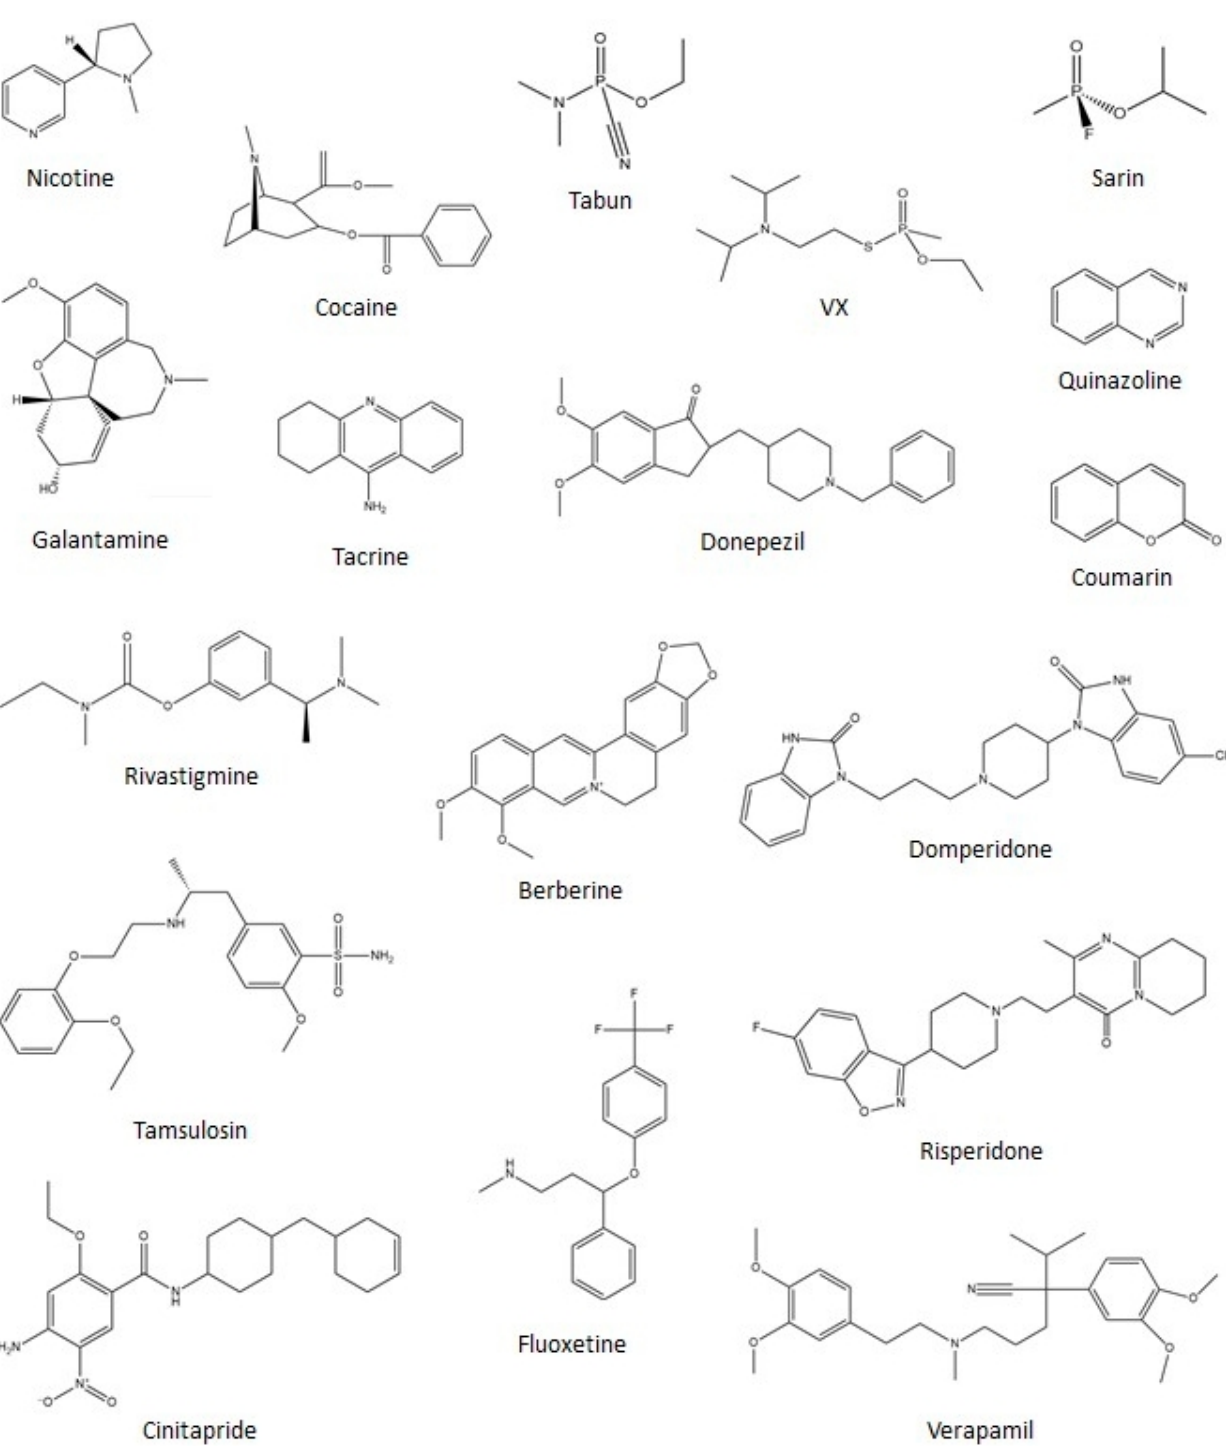
Figure 4. Chemical structures of various narcotic, nerve agent, and pharmaceutical cholinesterase inhibitors discussed in this review.